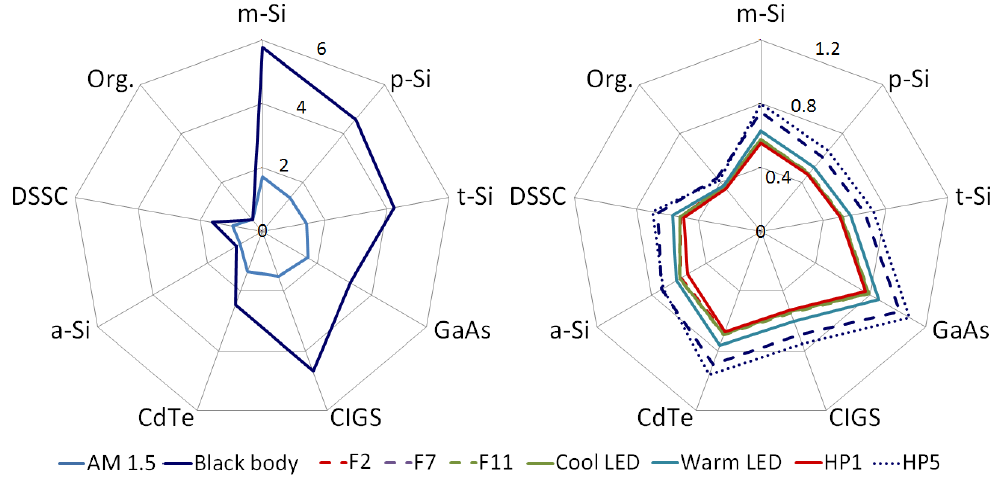
Figure 7. The calculated maximum electrical power output in W/m 2 of the different photovoltaic solar cells under different lighting conditions, for an illumination of 500